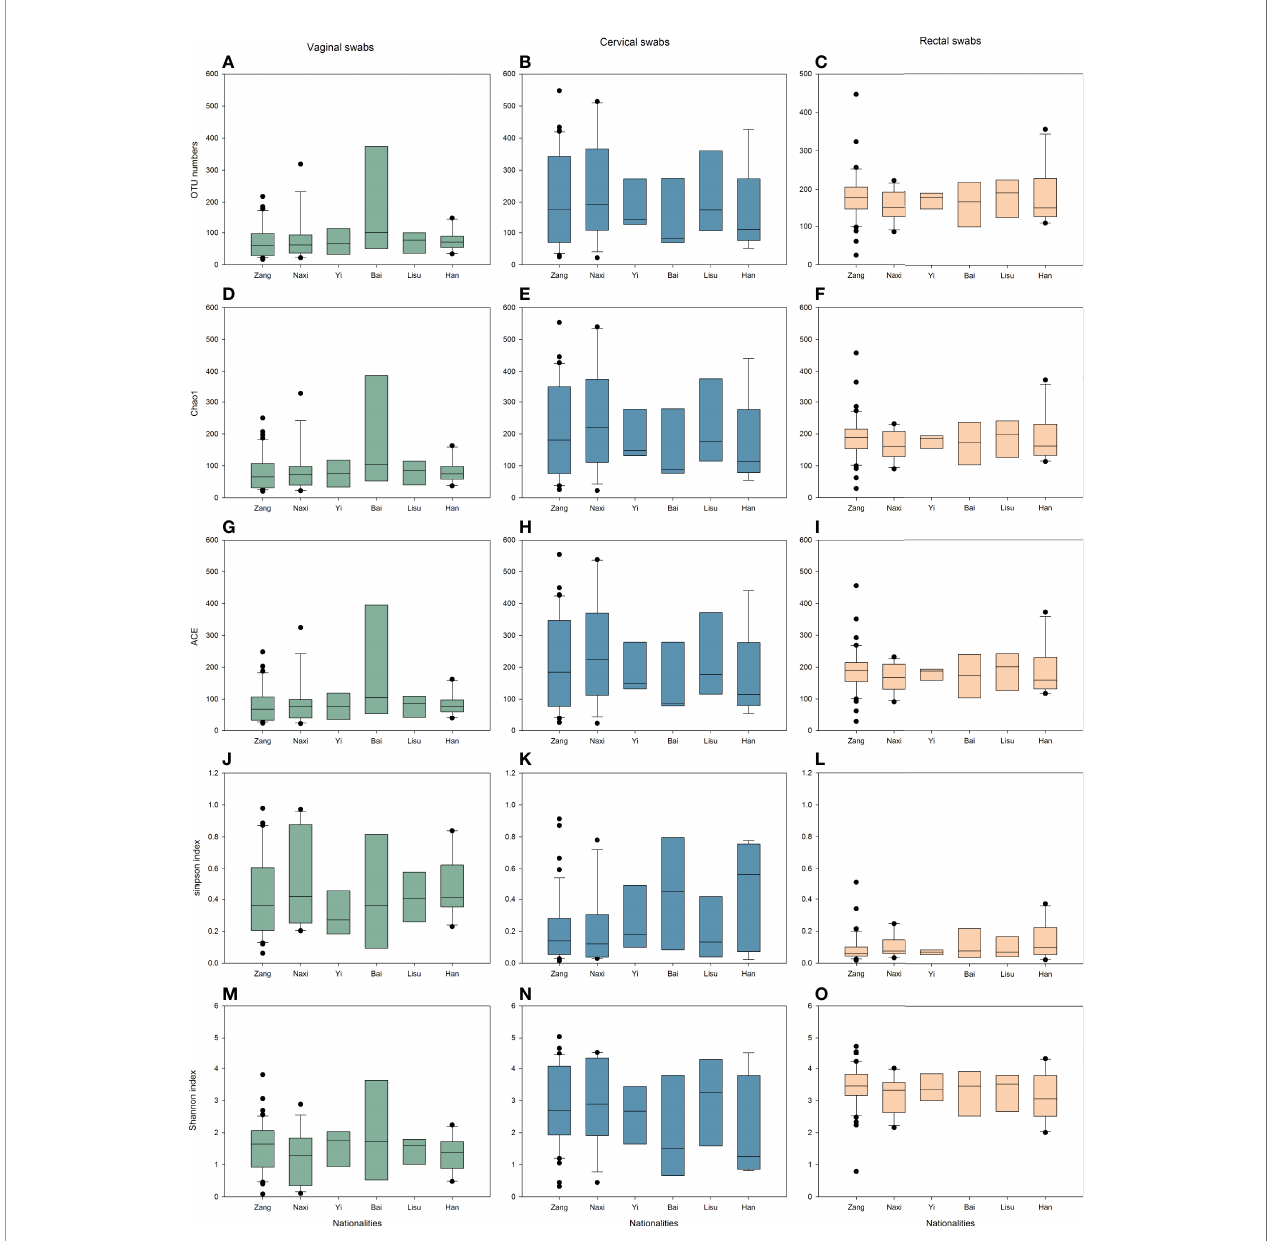
FIGURE 1 | Alpha diversity indices of vaginal (green), cervical (blue), and rectal (yellow) microbiota. (A – C) OTU numbers. (D – F) Chao1 indices. (G – I) ACE indices. (J – L) Simpson indices. (M – O) Shannon